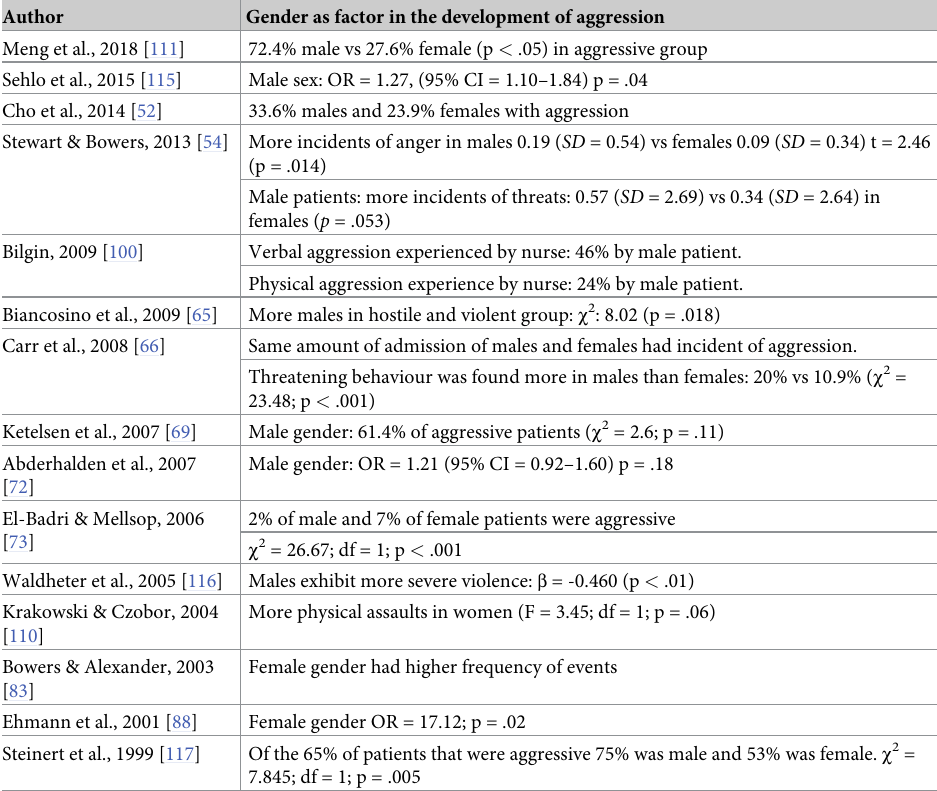
Table 3. Included studies on the possible association of gender and aggression development in